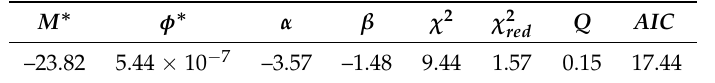
Figure 5. The observed LF for QSOs, empty stars with error bars, and the fit by the double power LF when the redshifts cover the range [ 0.3,0.5 ] Table 3. Parameters of the double power LF in the range of redshifts [ 0.3,0.5 ] when n = 10 and k = 4.